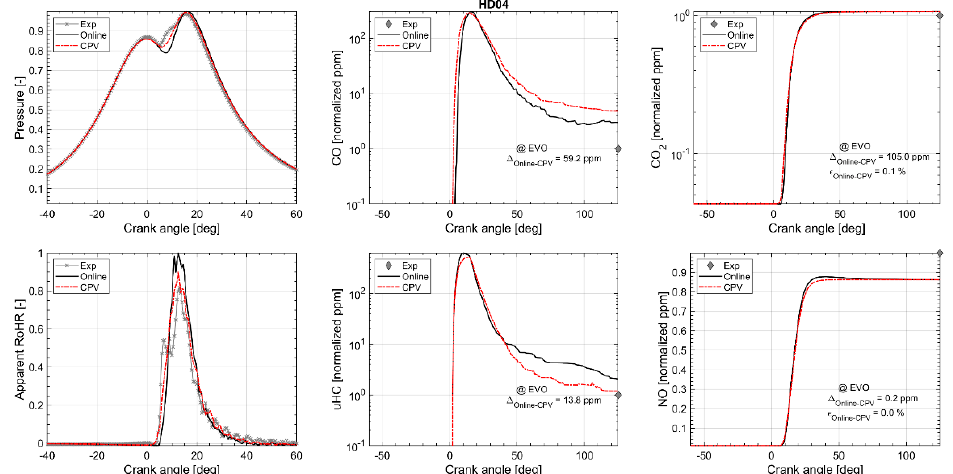
Figure A4. Engine performance and emissions for operating point HD04 (1300 rpm, 6.0 bar IMEP).